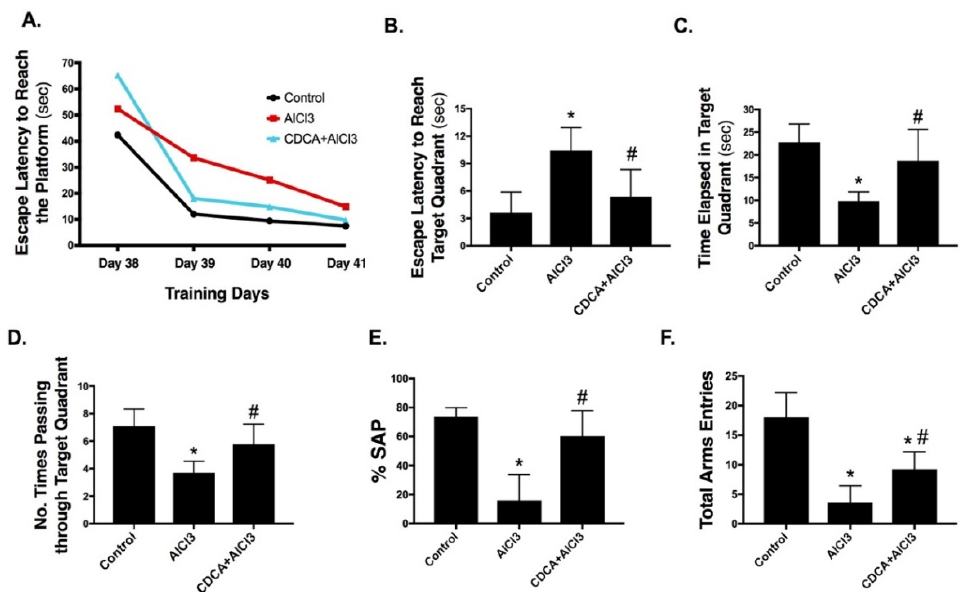
Figure 1. CDCA improves learning, spatial working memory and general activity in an AD rat model.